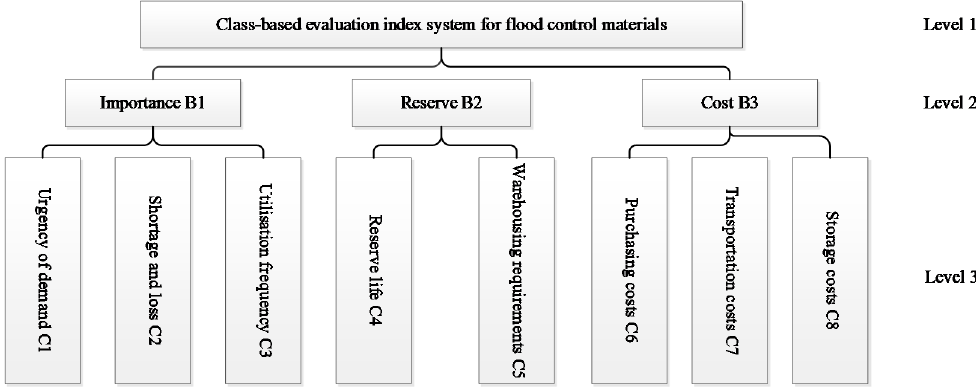
Figure 4. The evaluation index system and class-based model for flood control materials.